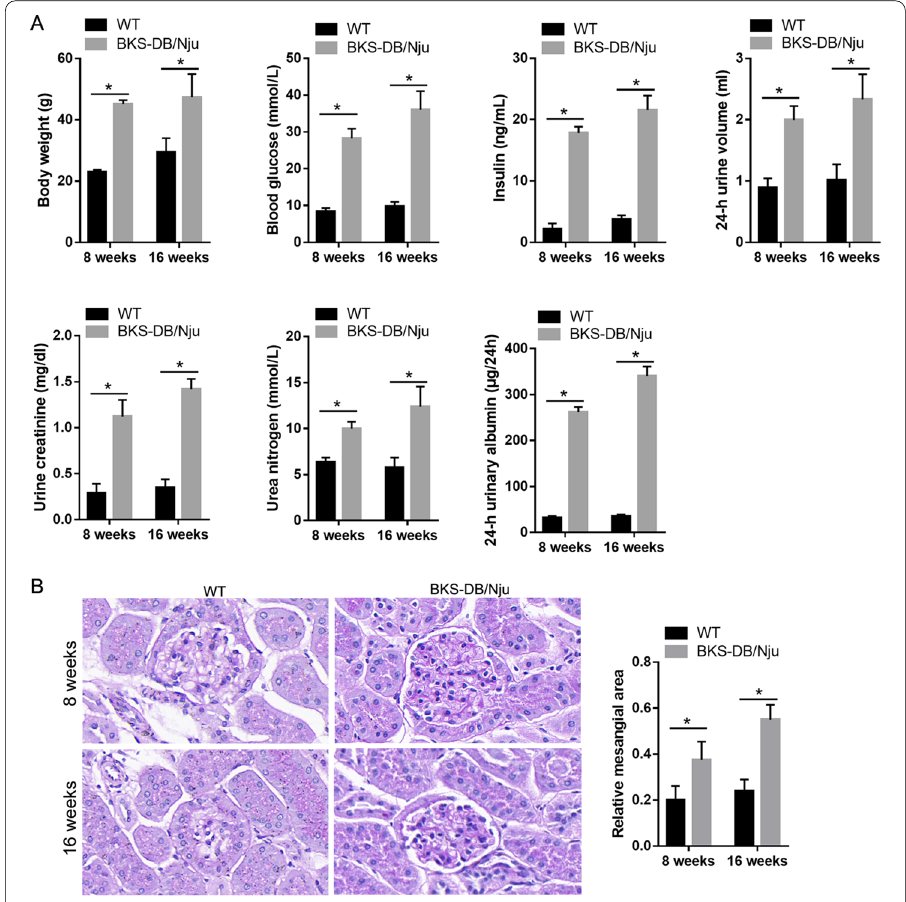
Fig. 1 Comparisons between diabetic nephropathy mice BKS-DB/Nju and wild-type (WT) mice at both 8 weeks and 16 weeks of age. A Comparisons of body weights and blood and urine biochemical parameters. B Periodic acid-Schiff (PAS) staining results of renal tissues. Representative graphs of PAS staining are shown at the top of the figure. Statistical results of relative mesangial area are shown on the right of the figure. Mesangial expansion was prominent in the glomeruli of BKS-DB/Nju mice. * P < 0.05, n